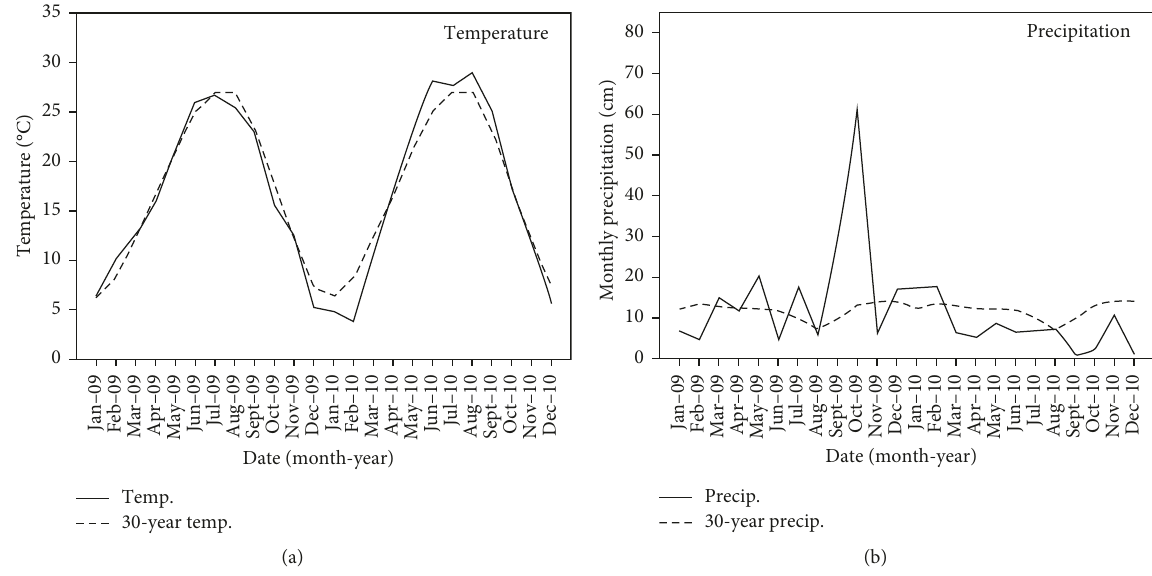
Figure 1: Monthly total precipitation, average monthly temperatures, and 30-year averages of precipitation and temperatures for a study site in North Central